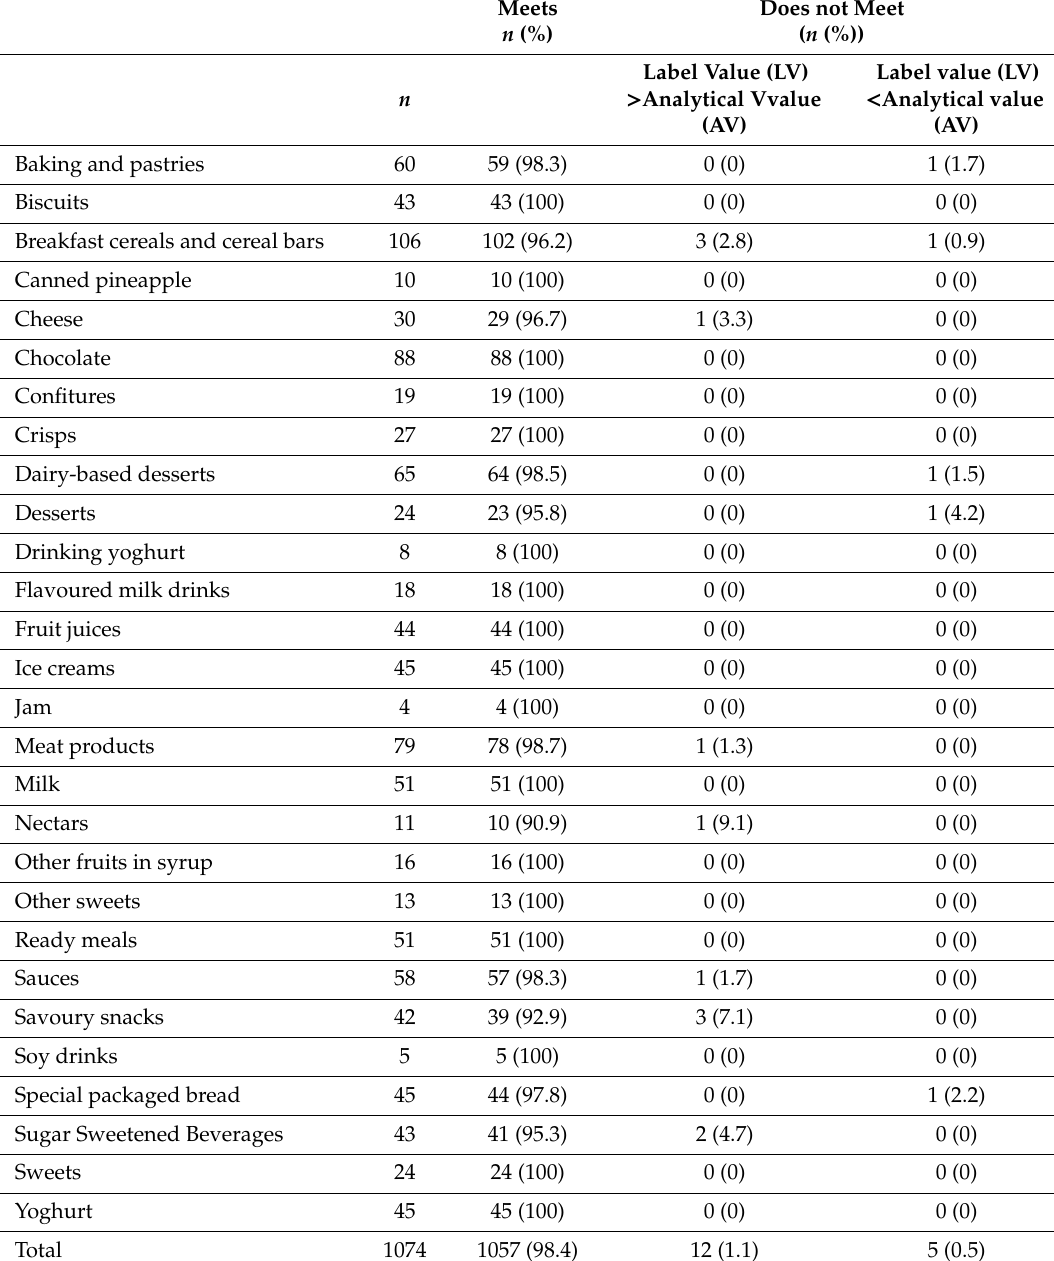
Table 3. Products that meet or do not meet the EU tolerance ranges.